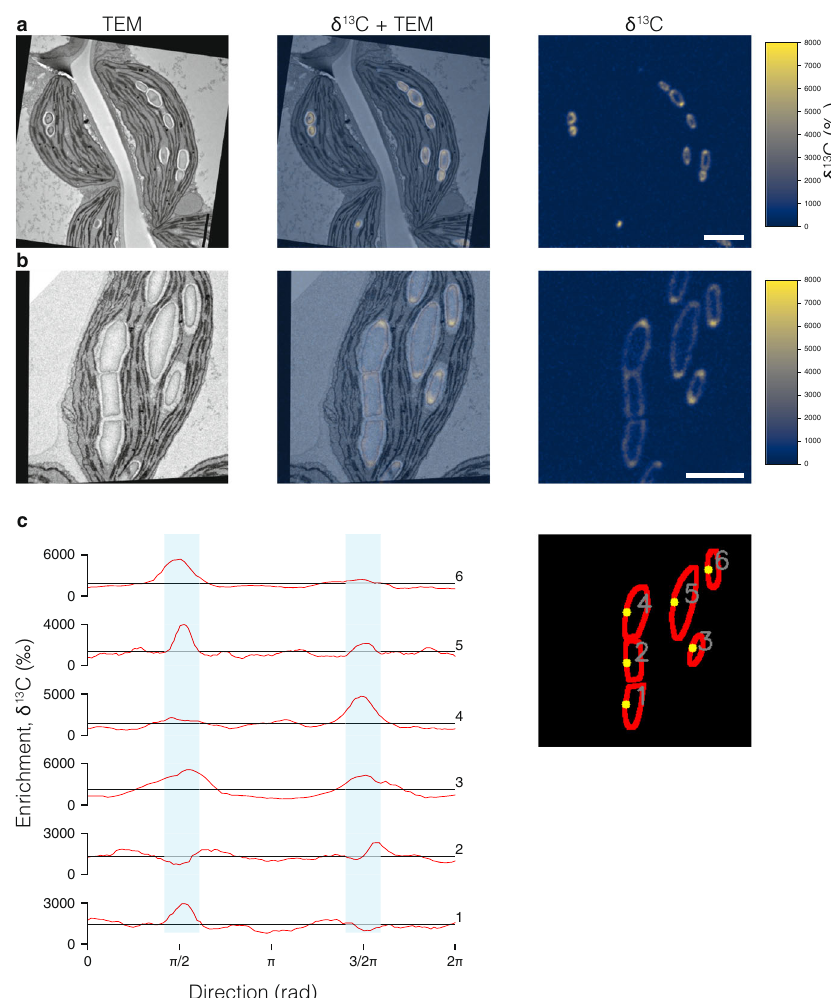
Fig. 4 Anisotropic starch granule expansion revealed by stable isotope labeling, EM, and NanoSIMS imaging. a Plants subjected to a 4-h night extension photosynthesized for 45 min in normal air, were labeled with a pulse of 13 CO 2 for 15 min, and then harvested immediately for EM and NanoSIMS imaging, as in Fig. 3. b Plants subjected to a normal night were labeled with a pulse of 13 CO 2 for 1 h at midday then harvested immediately. Scale bars: 2 µ m. c Quanti fi cation of 13 C-enrichment on the surface of six granules depicted in b . The probing regions (depicted in red in the inset, right) were de fi ned manually with masks over the δ 13 C map. Individual circular pro fi les were extracted anticlockwise from the starting point (yellow). Light blue segments highlight the parts of the pro fi les corresponding to the granule margins, where most enrichment is observed. Horizontal lines show the mean enrichment for each pro fi